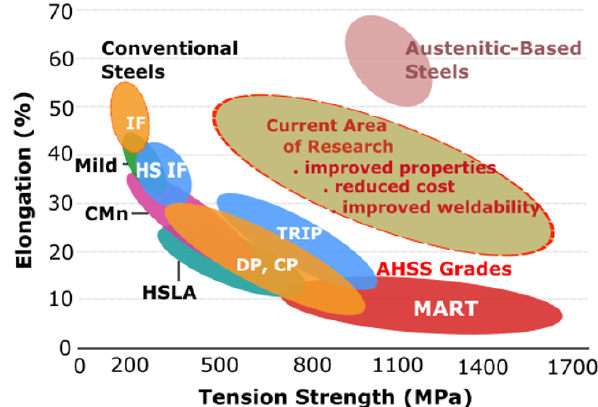
Figure 1: Strength distribution of different types of steels and the zone of the third generation of steels, an object of the current area of research [4, 7,